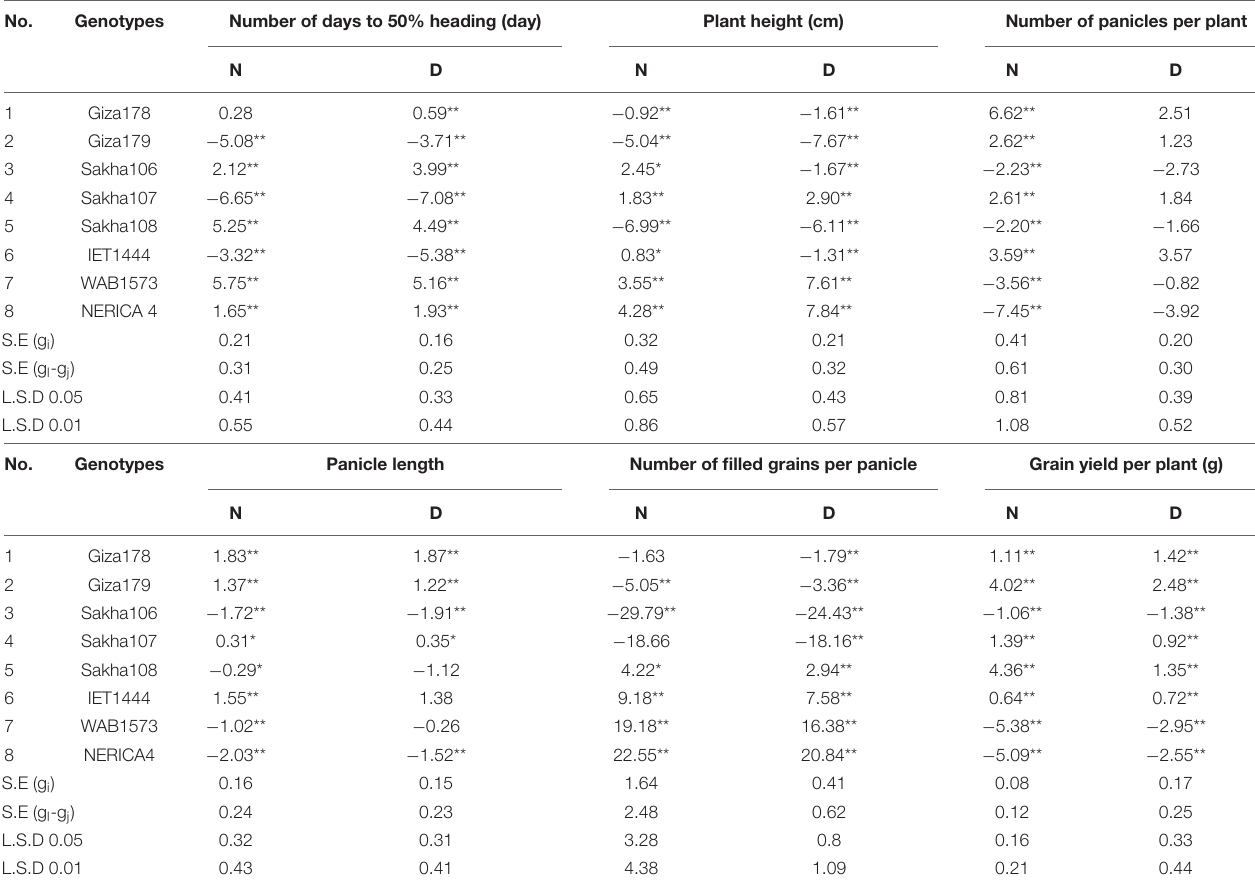
TABLE 5 | Estimates of general combining ability effects for yield and some related traits for parental genotypes under normal and water stress conditions.